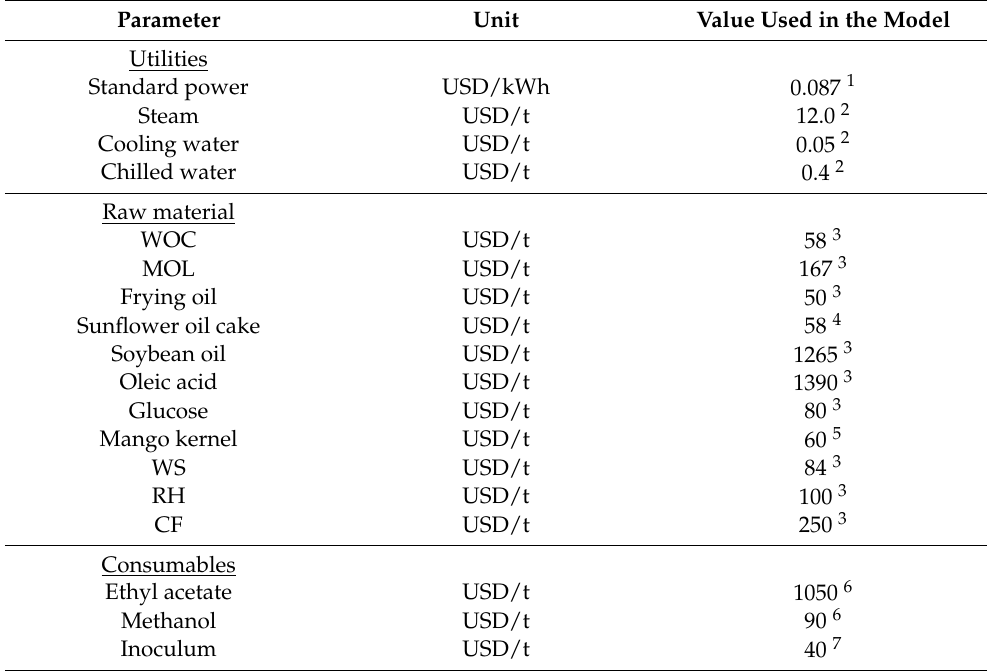
Table 2. Prices for utilities, main raw materials, and products in the presented scenarios. Parameter Unit Value Used in the Model Utilities Standard power USD/kWh 0.087 1 Steam USD/t 12.0 2 Cooling water USD/t 0.05 2 Chilled water USD/t 0.4 2 Raw material WOC USD/t 58 3 MOL USD/t 167 3 Frying oil USD/t 50 3 Sunflower oil cake USD/t 58 4 Soybean oil USD/t 1265 3 Oleic acid USD/t 1390 3 Glucose USD/t 80 3 Mango kernel USD/t 60 5 WS USD/t 84 3 RH USD/t 100 3 CF USD/t 250